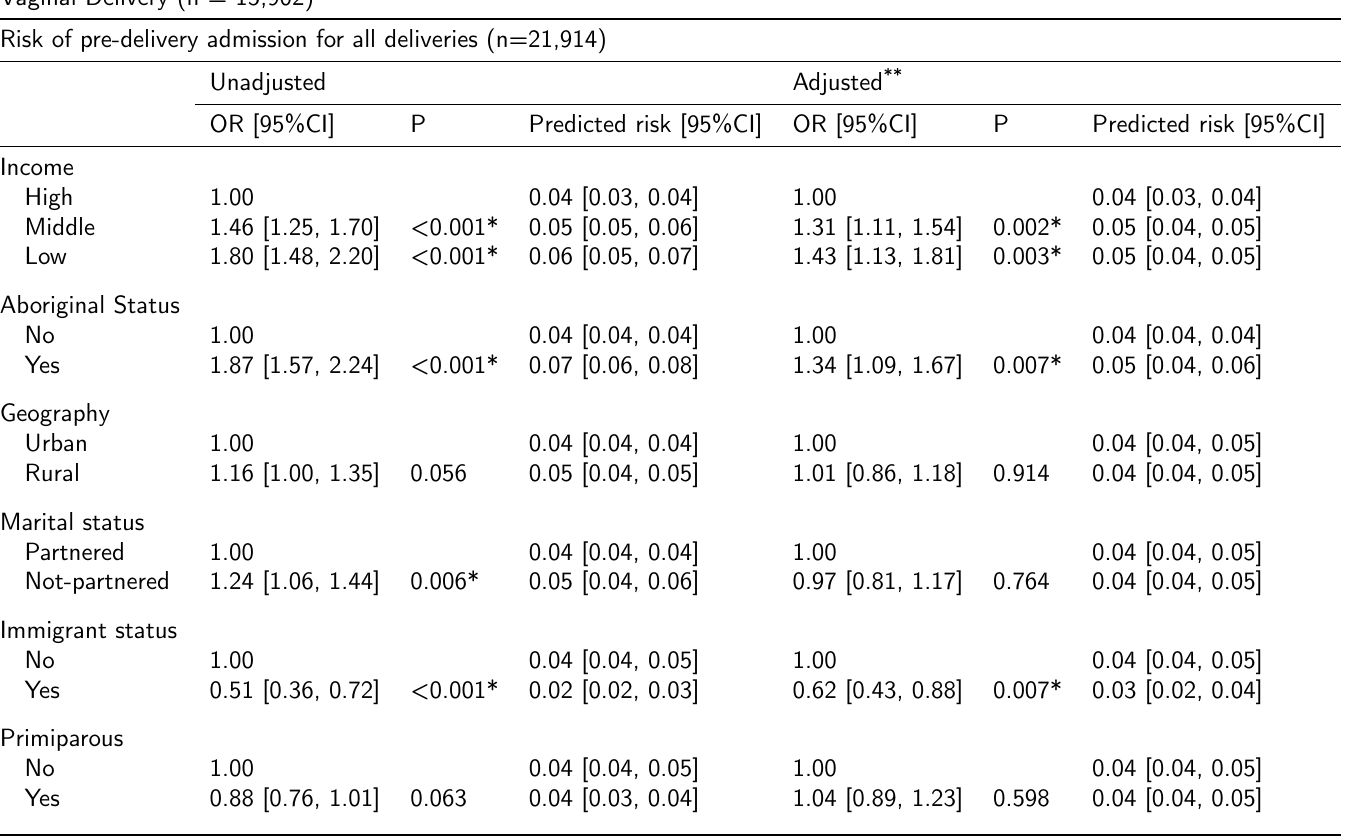
Vaginal Delivery (n =